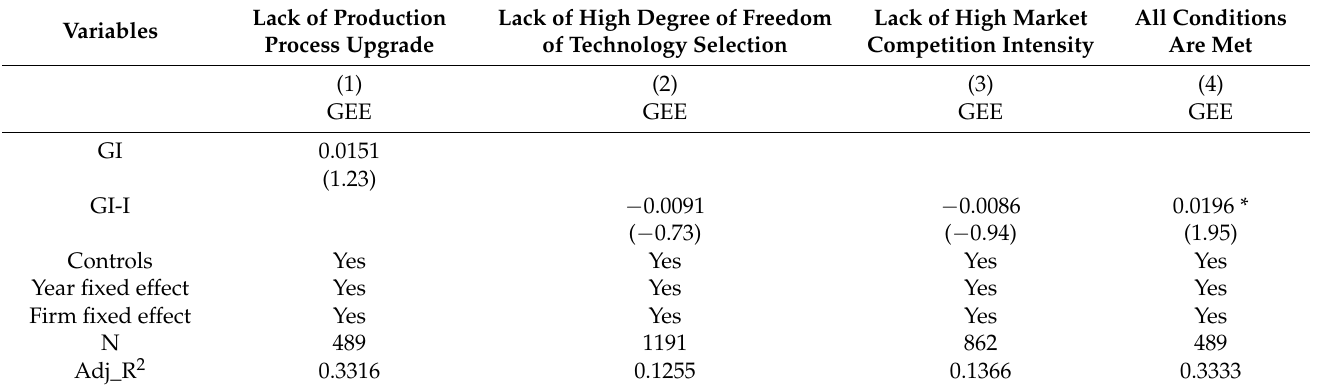
Table 8. The positive impact of green innovation on green economic